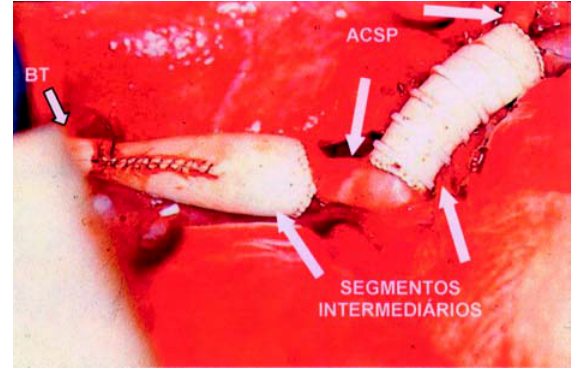
Fig. 10 – Blalock-Taussig modificado (BT) associado à unificação de artérias colaterais sistêmico-pulmonares (ACSP) em seg- mentos arteriais intermediários